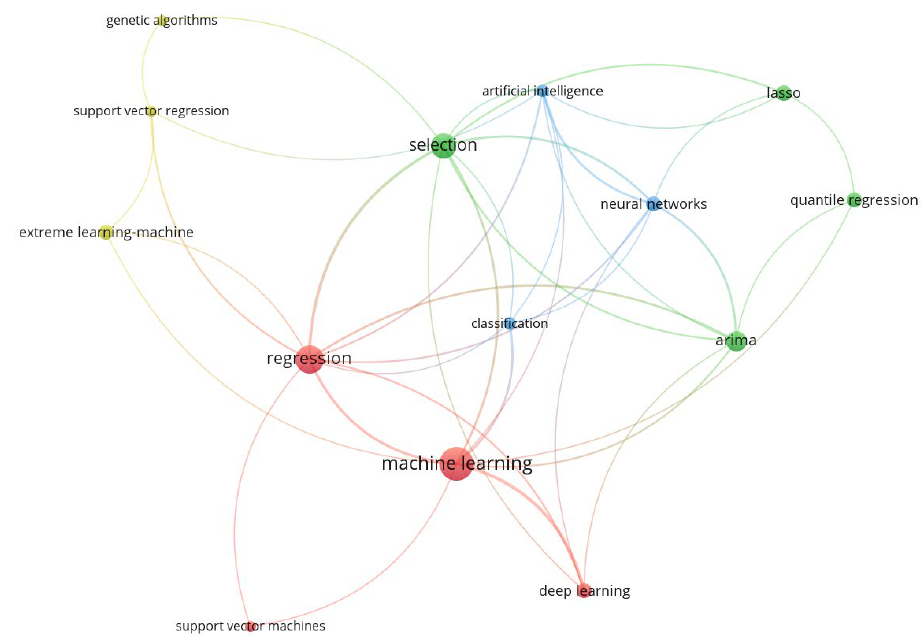
Figure 3. Bibliometric map of keywords co-occurrences results from WoS based on original Query 2. Source: Authors’ elaboration performed in the VOSviewer (version 1.6.18).